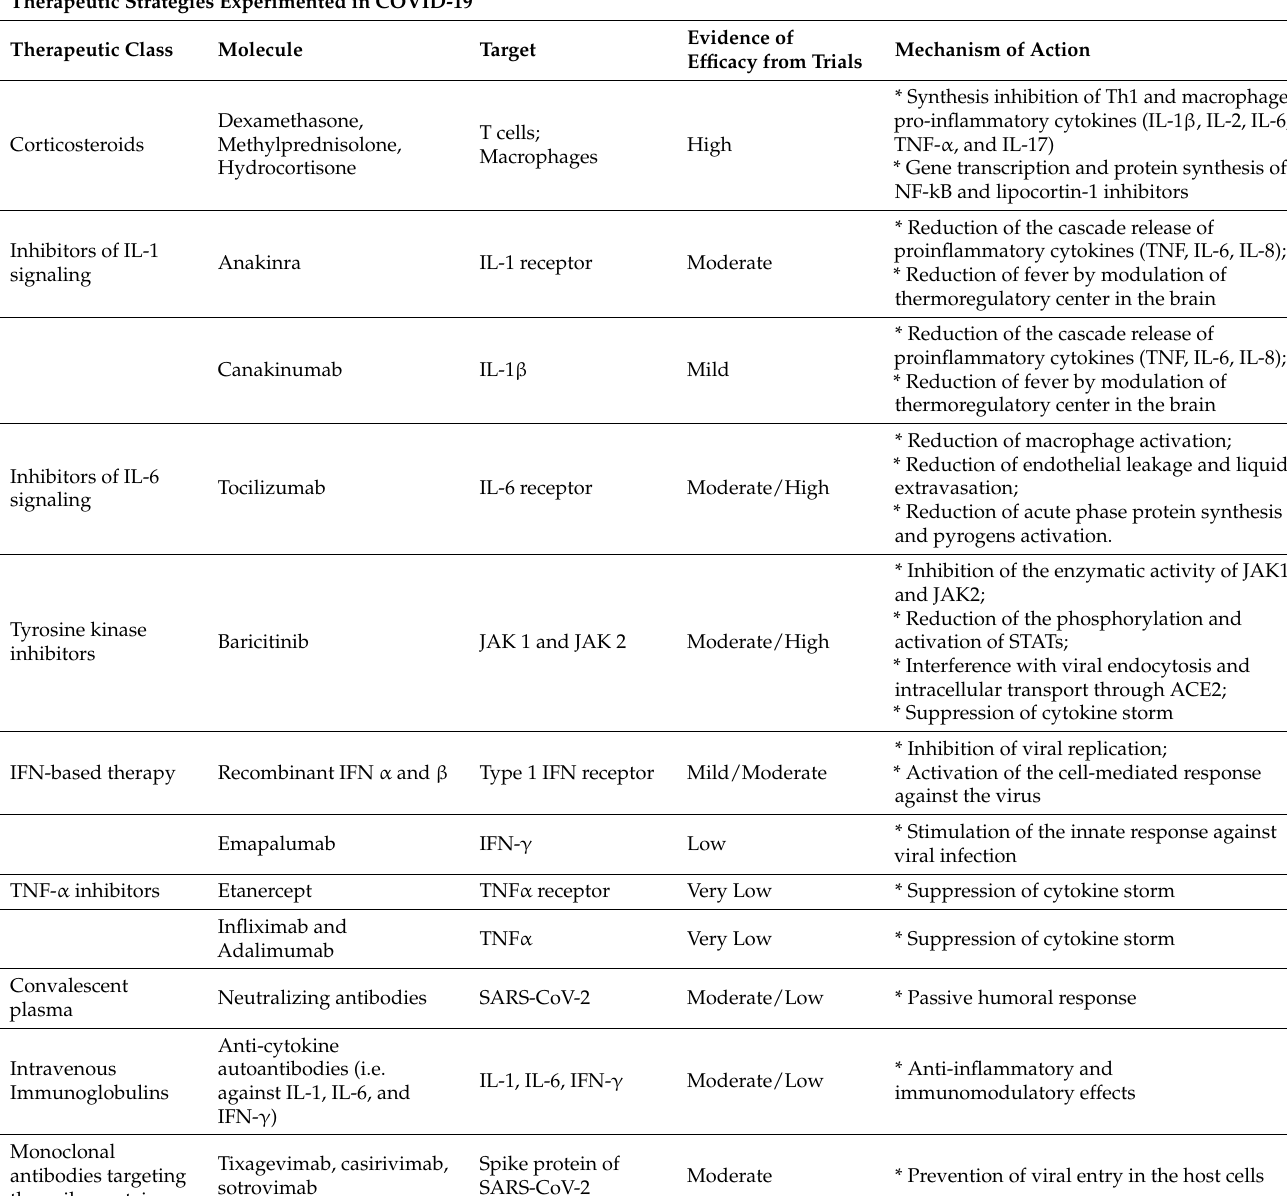
Table 1. Therapeutic agents that have been tested for the treatment of COVID-19. For every agent, the therapeutic class, molecule, target and mechanism of action have been described. A quality of evidence for the efficacy has also been specified, according to data available from trials and observational studies already available in the literature. IL, interleukin; TNF, tumor necrosis factor; JAK, Janus kinase; STAT, signal transducers and activators of transcription; IFN, interferon; NF-kB, nuclear factor kappa; ACE2, angiotensin-converting enzyme